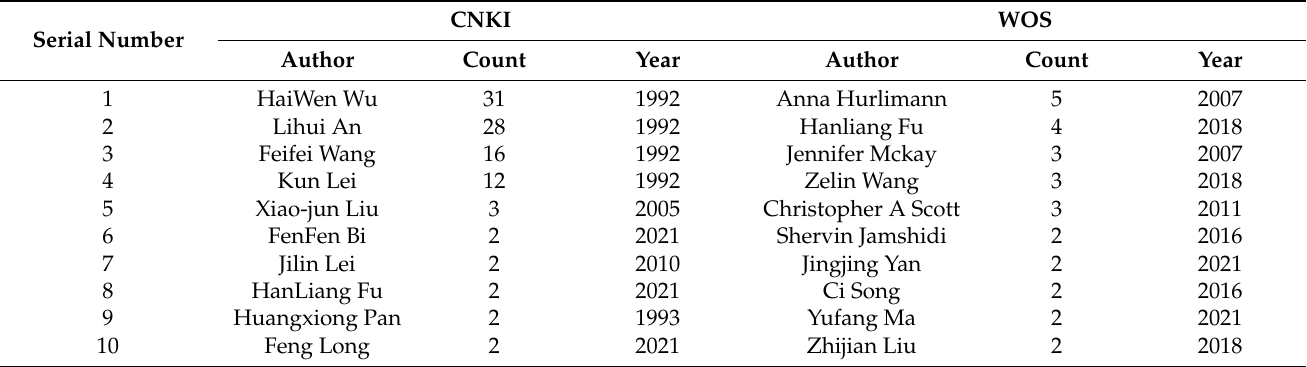
Table 2. Comparison of number of articles published by research authors (top